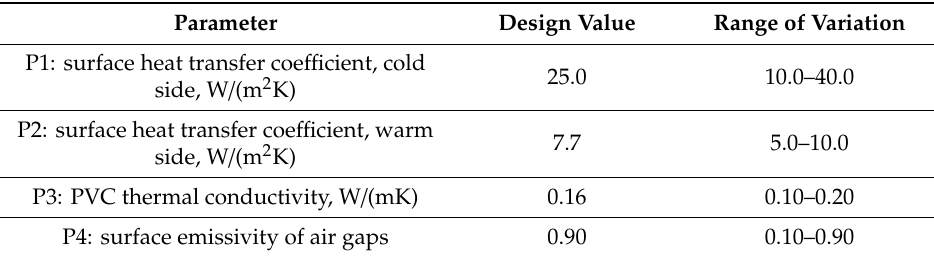
Table 4. Ranges of parameters variation in the sensitivity